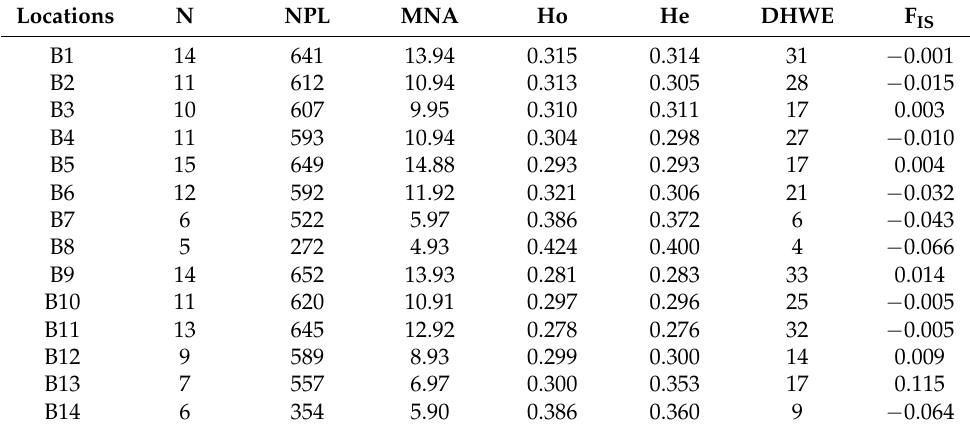
Table 2. Genetic diversity for trout population from Biferno stations. N—number of